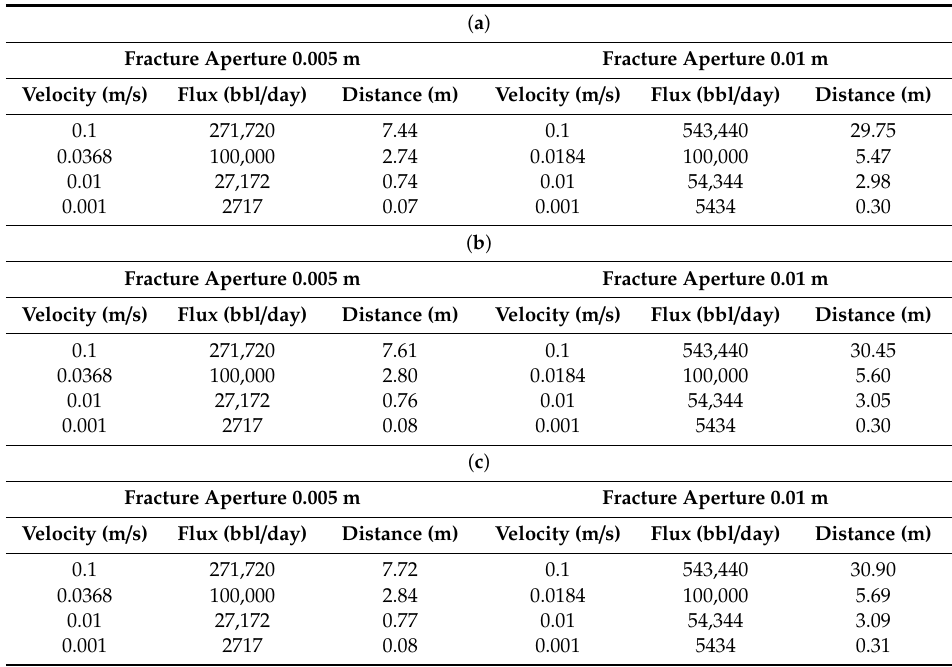
Table 3. ( a ) Brine travel distance needed to reach 90 °C for fracture temperature 100 °C. ( b ) Brine travel distance needed to reach 112.5 °C for fracture temperature 125 °C. ( c ) Brine travel distance needed to reach 135 °C for fracture temperature 150 °C.